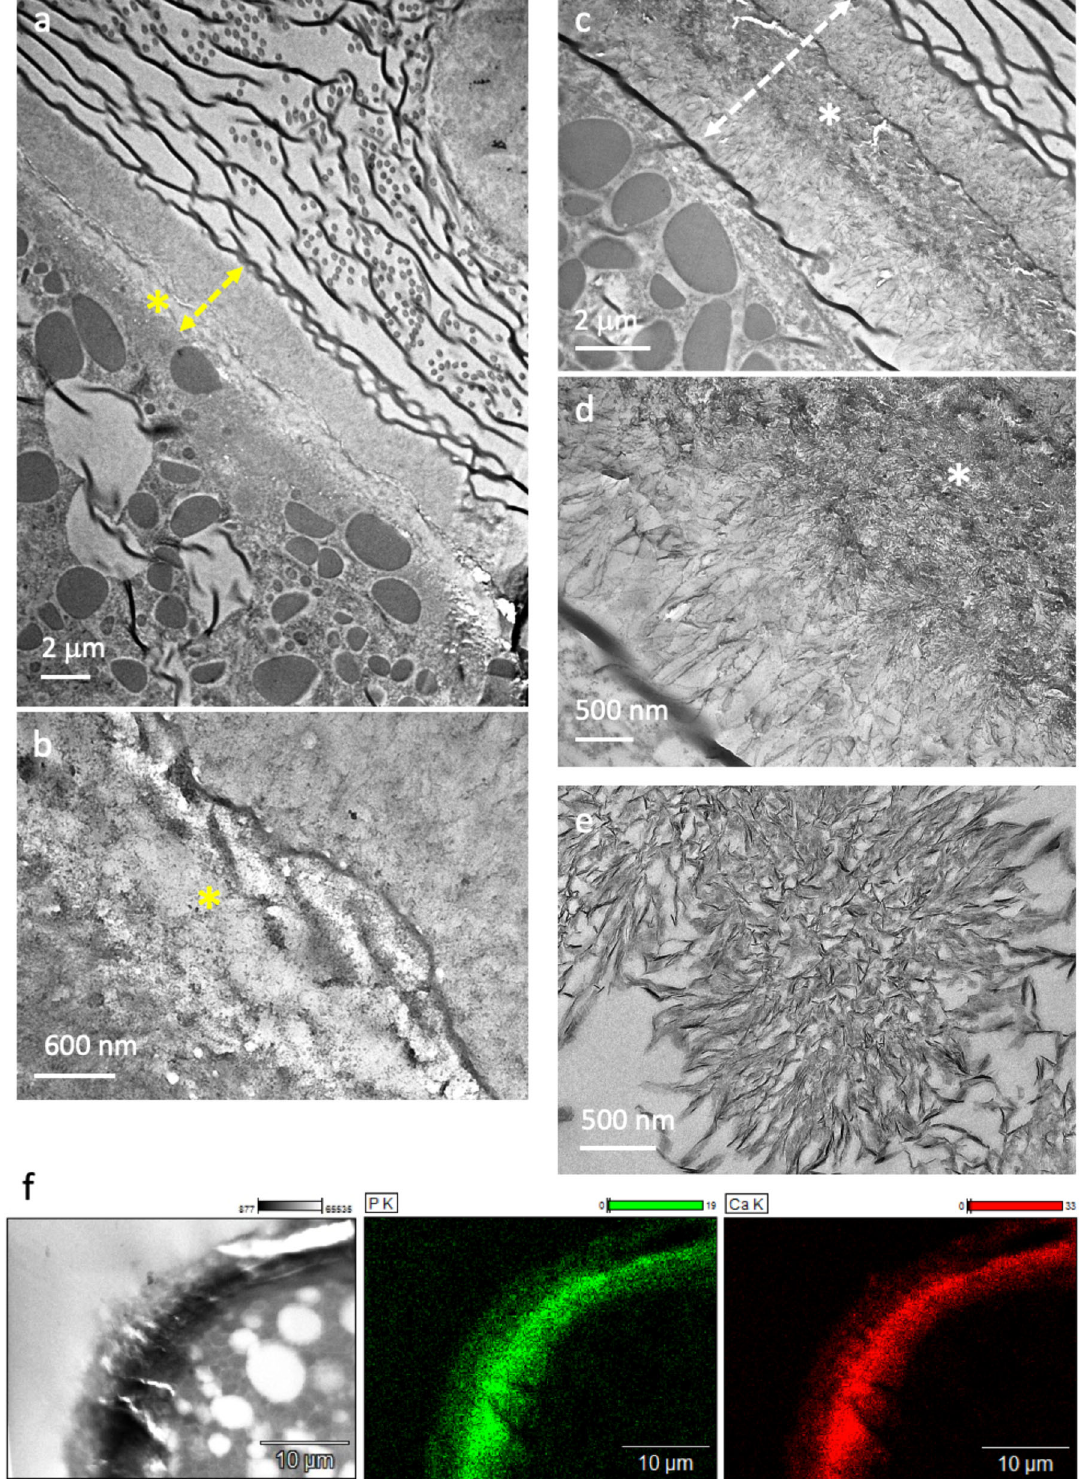
Fig. 3 Ultrastructure and chemical composition of 48 hpf larval shell of H. tuberculata . TEM micrographs of the shell sections (double-headed dashed arrow) a – d at low magni fi cation a , c showing two ( a , b ) or three ( c , d ) layers. Stars (*) show the less (yellow in a-b) and the more (white in c , d ) contrasted layer. At higher magni fi cation b , d , the presence of thin radial oriented particles reminding e in vitro spherulitic apatite observed in cross-section by TEM; f STEM-EDX analysis performed on the larval shell in cross-section showing the STEM micrograph of the analyzed region (left) and images from the related chemical analysis where the presence and the co-localization of phosphate (green) and calcium (red) is